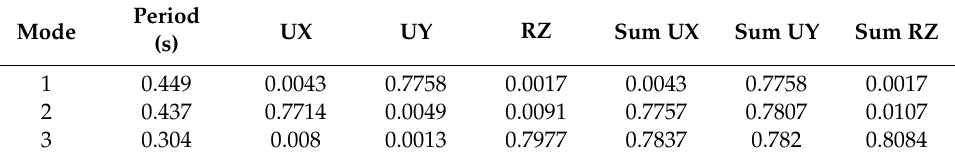
Table 9. Ratios of the modal participating mass after the reducing of the torsion.